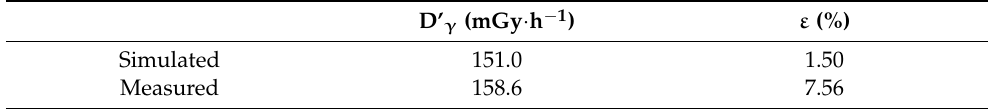
Figure 5 . Photon dose profile on the y -axis ( up ) and x -axis ( down ). Figure 5. Photon dose profile on the y -axis ( up ) and x -axis ( down ). TLD-700H yielded a systematically higher photon dose (by 14%) over TLD-500, which may be due to the application of nominal neutron sensitivity values. From this, an uncer- tainty of 10% was estimated for the photon dose measurements retrieved by the average results with both materials. The gamma dose in air showed an agreement of 95% between simulations and measures (Table 3) that is clearly smaller than the measurement uncertainty. Table 3. Comparison of simulated and measured values for photon dose rate D’ γ and their respective relative uncertainties ε